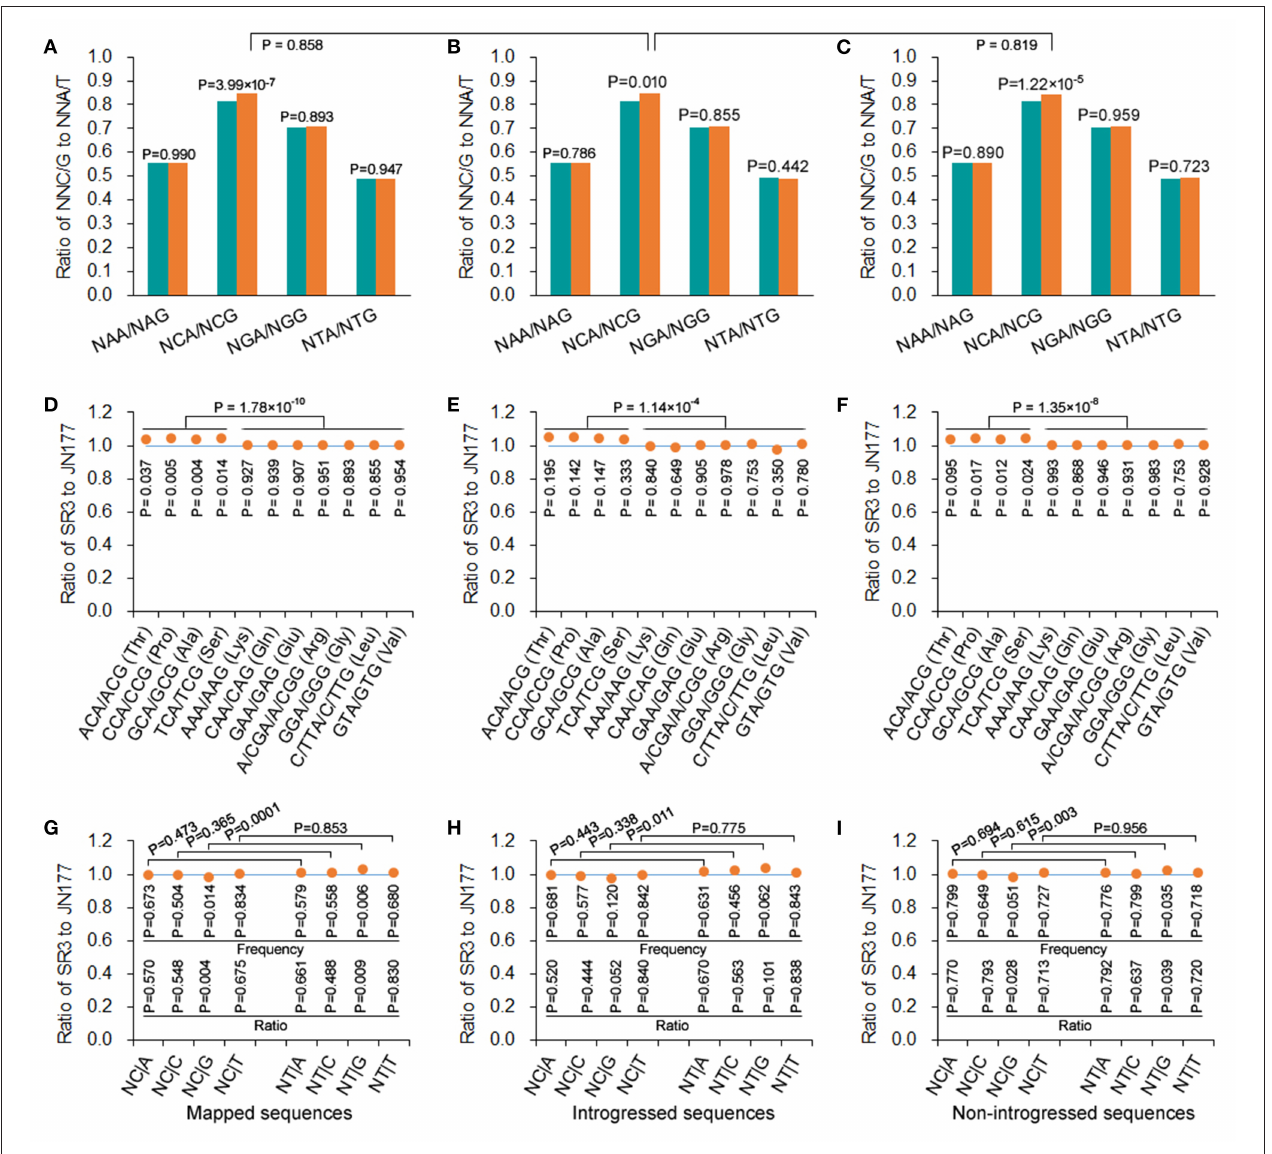
FIGURE 4 | DNA methylation-driven SCUB shift was more pronounced. (A–C) The ratio of NNA frequency to NNG frequency. (D–F) The ratio of the number of NNA to NNG codons encoding a given amino acid. (G–I) The ratio of the frequency of NC|N adjacent codons and NT|N adjacent codons between SR3 and JN177. In (D) to (F) , the difference in the ratios of Thr, Pro, Ala, and Ser from the ratios of other amino acids was calculated using t -test. The other statistical comparison was conducted with chi square ( χ 2 ) test of fourfold cross-table analysis.